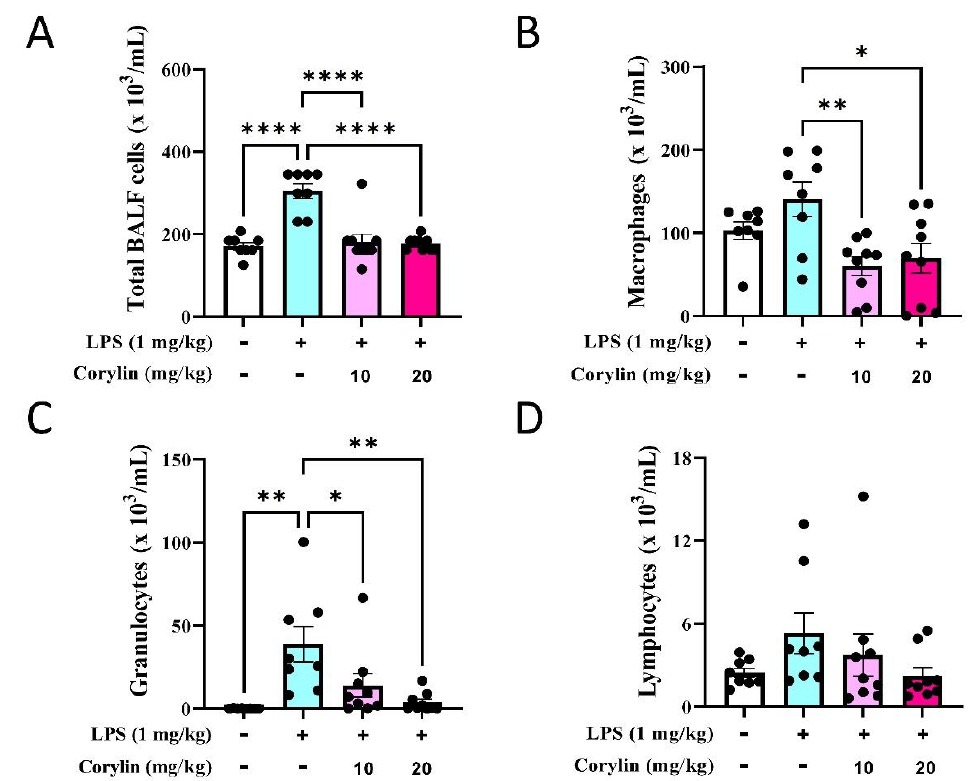
Figure 3. Effects of corylin treatment on immune cell infiltration in BALFs in LPS-induced mice. BALFs were collected from LPS and/or corylin-treated mice. ( A ) The total cell numbers in BALFs. The cell subsets were identified by multi-color flow cytometry, including ( B ) macrophages, ( C ) granulocytes, and ( D ) lymphocytes. Results are shown as mean ± SEM. * p < 0.05, ** p < 0.01, and **** p < 0.0001 vs. LPS alone by one-way ANOVA followed by post hoc Tukey’s test. The numbers of mice are pooled from two independent experiments ( n = 8~10).